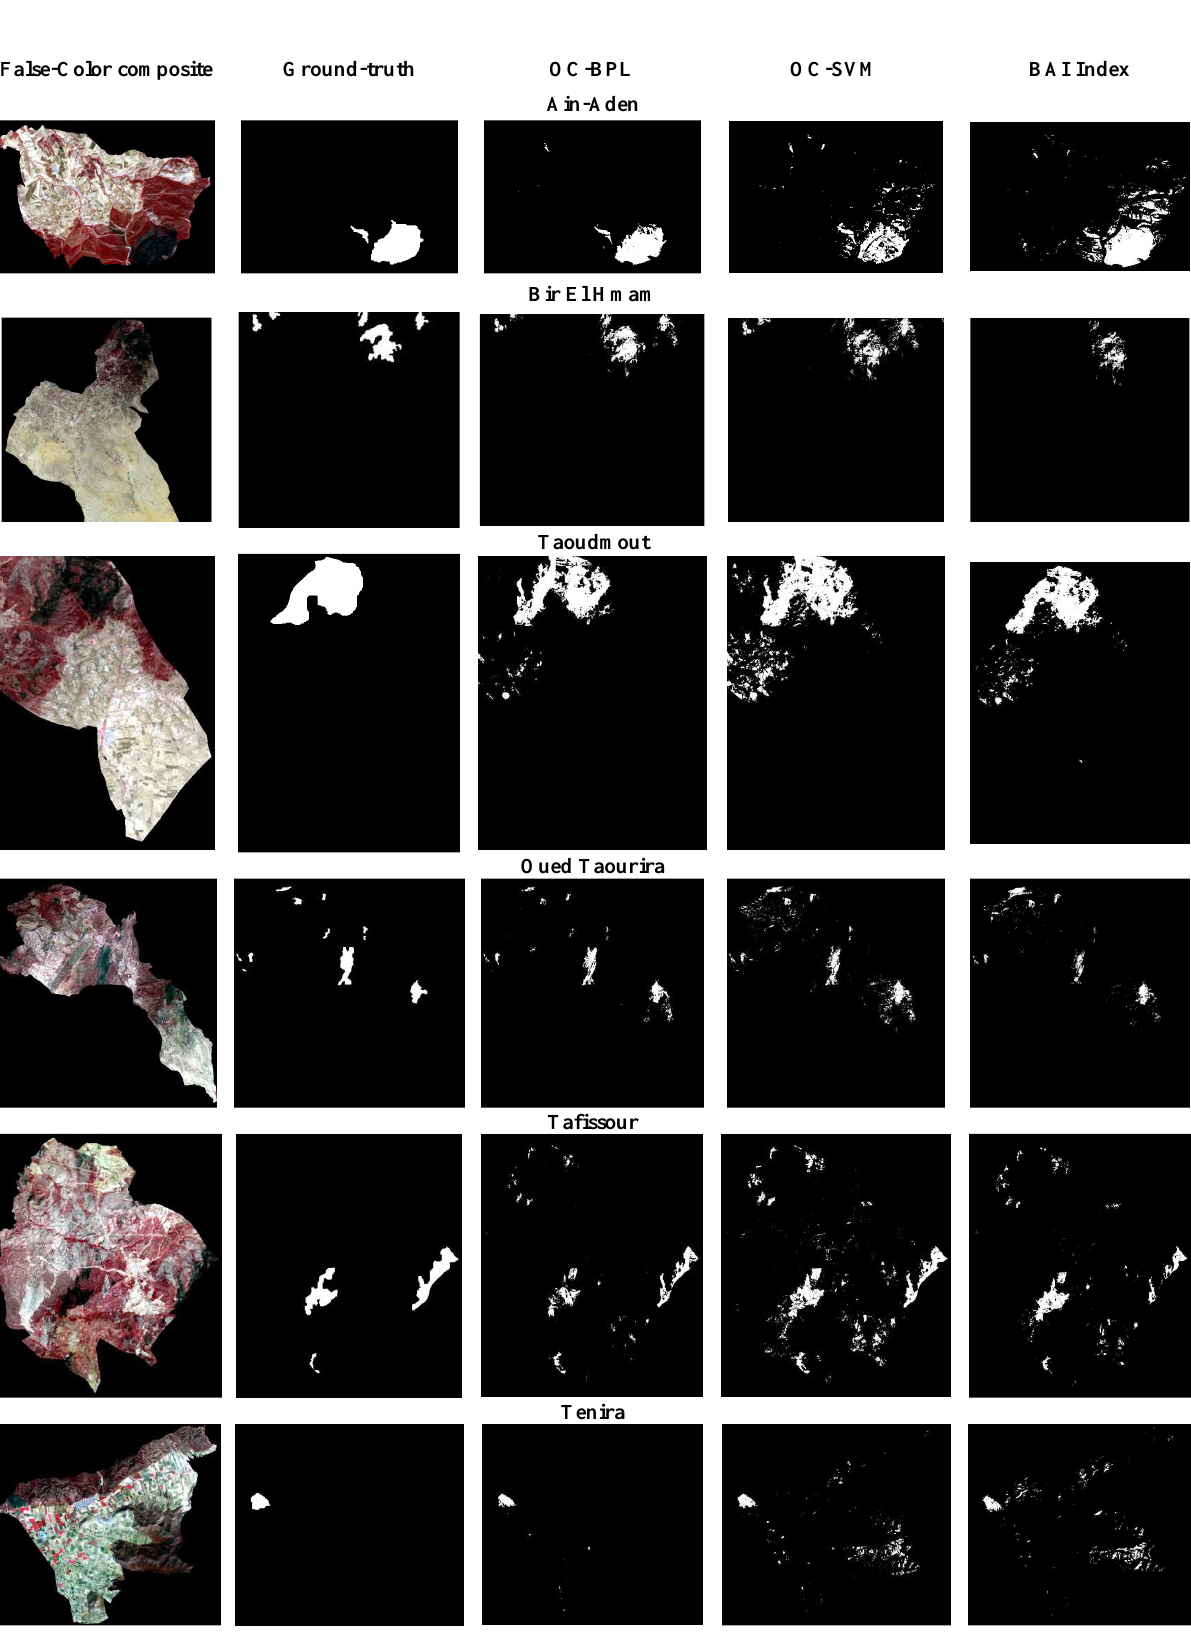
Table 2. Results of extraction of burned areas (from left to right: false color composite image, Ground truth, PBL, OC-SVM